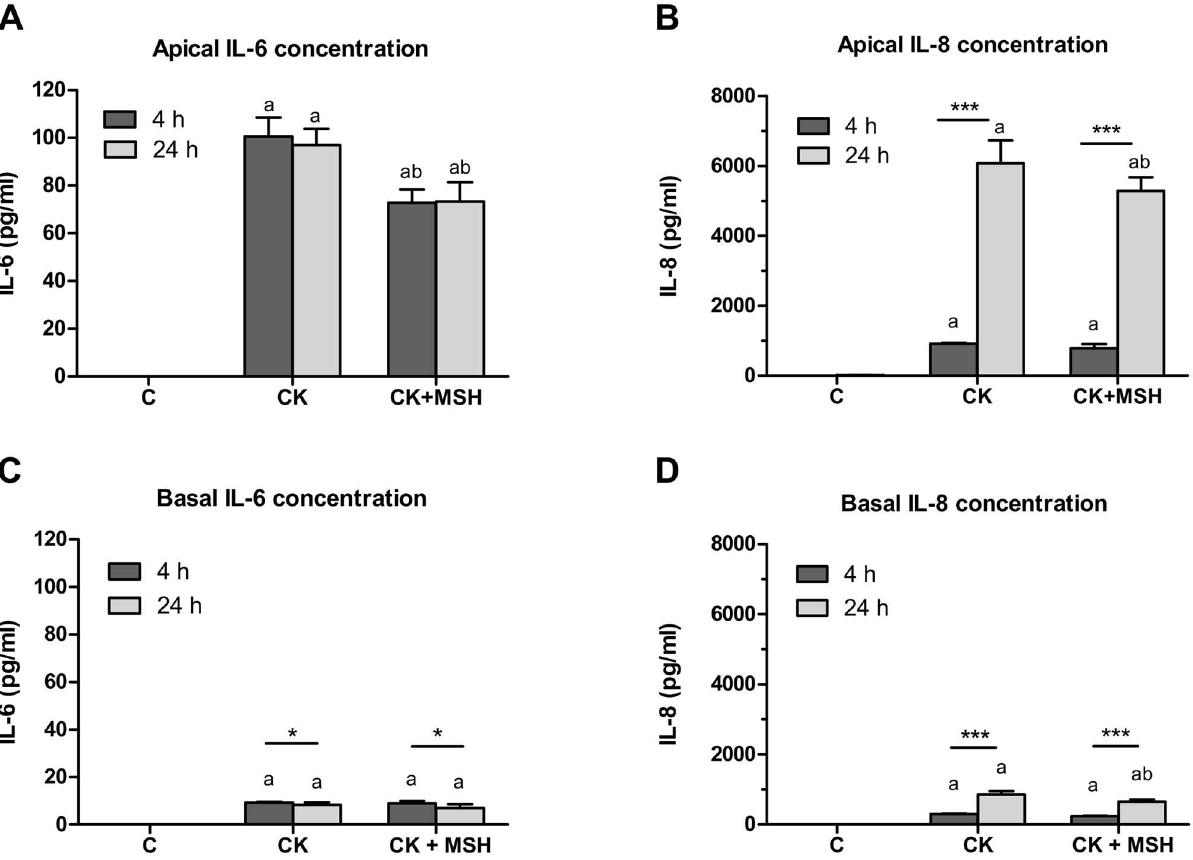
Fig 6. Secretion of IL-6 and IL-8 in Caco-2 cells treated with cytokines and α -MSH. Caco-2 monolayers grown on culture inserts were treated with cytokines (CK; 50 ng/ml TNF- α and 25 ng/ml IL-1 β ) without or with α -MSH (10 − 8 M) for 4 and 24 hours. The control group (C) received culture medium. Culture medium sampleswere collectedfrom the apical and basal compartments. The concentration of IL-6 (6A and 6C) and IL-8 (6B and 6D) secreted by Caco-2 cells were measuredby multiplexed flow cytometric bead array assays. Means ± S.D., n = 3–5, *** P < 0.001, * P < 0.05; a: CK, CK+ MSH comparedto C, P < 0.001; b: CK+ MSH comparedto CK, P < 0.001